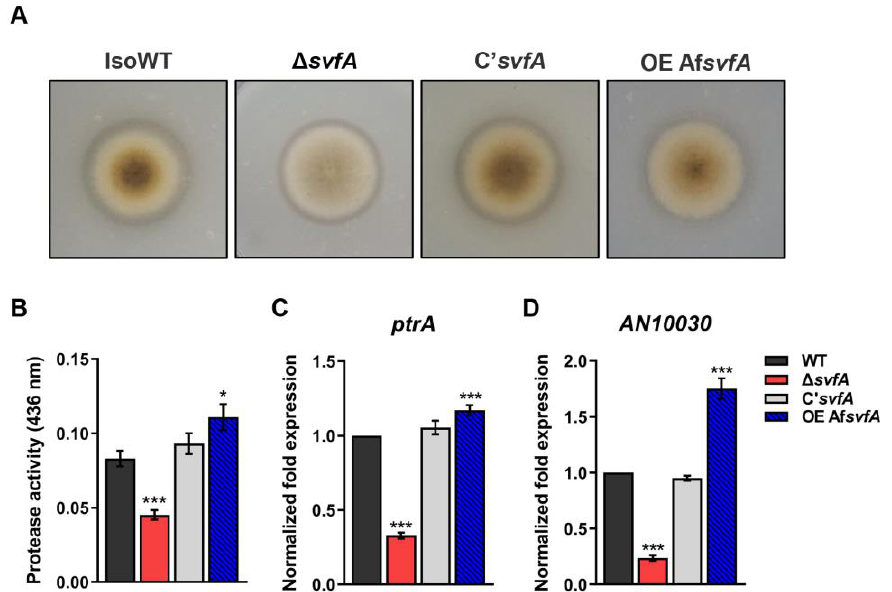
Figure 2. Role of SvfA in protease production. ( A ) Halo formed at edge of colonies of WT, ∆ svfA , C’ svfA , and OEAf svfA A. nidulans strains. Conidia were point-inoculated on Czapek–Dox medium containing 1% skim milk and incubated at 37 ◦ C. ( B ) Quantification of proteolytic activity. Supernatants were obtained from the 3 d cultures in Czapex–Dox broth containing 1% skim milk. Protein concentrations were calculated using a BCA protein assay kit. Protease activity was evaluated using an azocasein assay. N = 10. ( C , D ) Relative expression of the putative alkaline protease genes ptrA and AN10030 . Total RNA was extracted from mycelial balls incubated in Czapex–Dox broth. RT-qPCR analysis was performed using the 18S rRNA gene as an internal control. N = 15 – 18. * p ˂ 0.05, *** p ˂ 0.001.